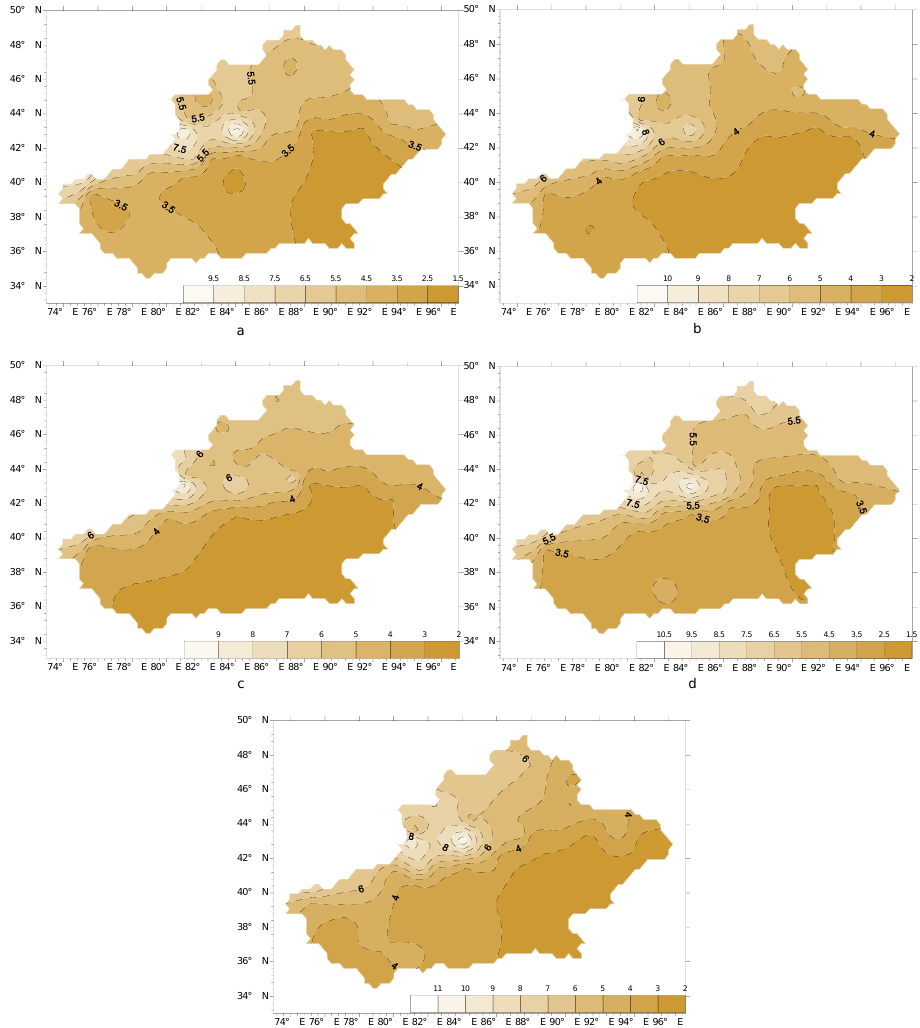
Figure 7 Fig. 7. Spatial and temporal distribution of decadal average CWD in Xinjiang: (a) 1961–1970; (b) 1971–1980; (c)